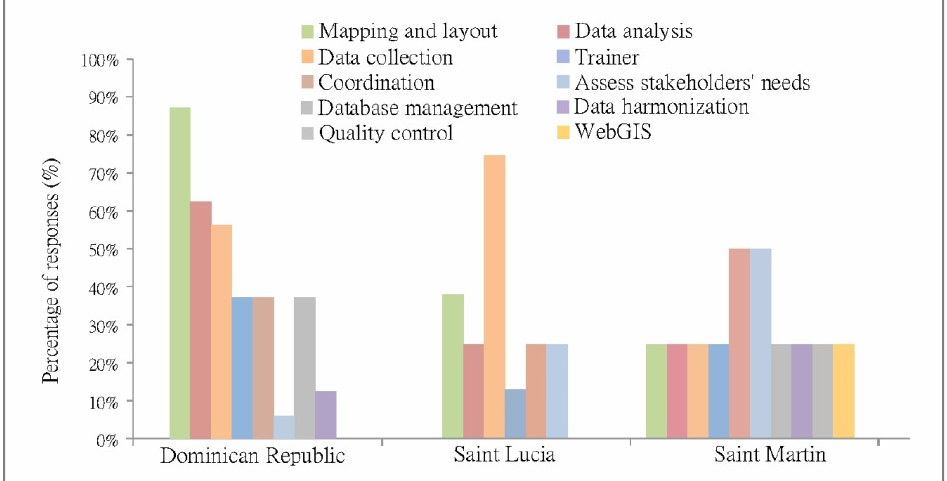
Figure 4. Distribution of responses by participants’ tasks (Q9).